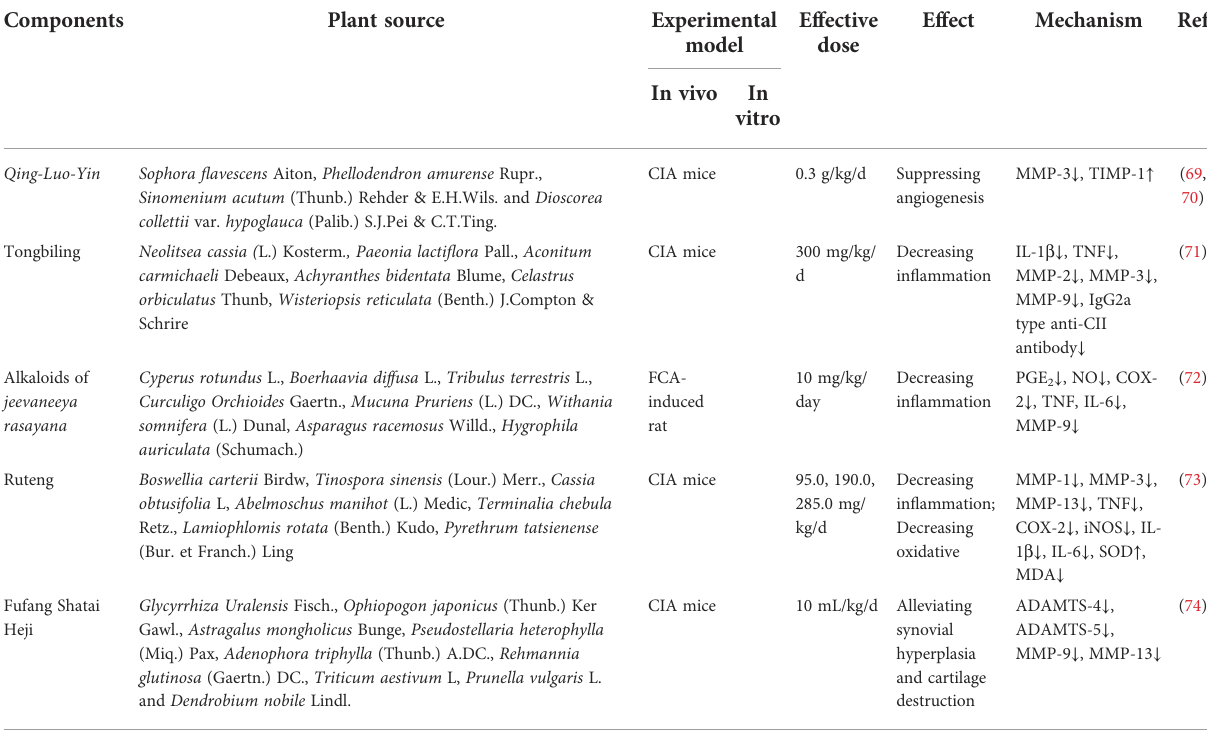
TABLE 1 Herbal medicine formulas that can treat rheumatoid arthritis by regulating MMPs.